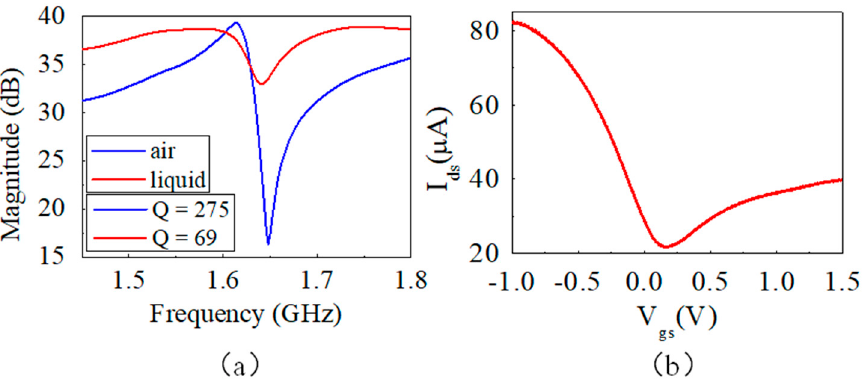
Figure 3. ( a ) Magnitude of electrical impedance at various frequencies and the Q values of the device in the air (blue curve) and in liquid (red curve). ( b ) Transfer characteristics of the graphene FET.